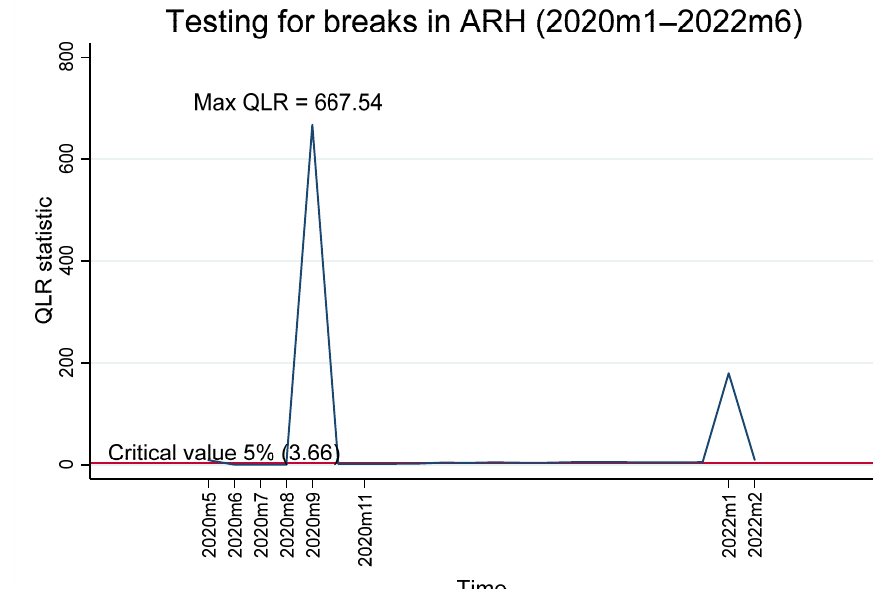
Figure 4. QLR test for the actual rentals for housing (ARH) over the period 2020m1–2022m6.